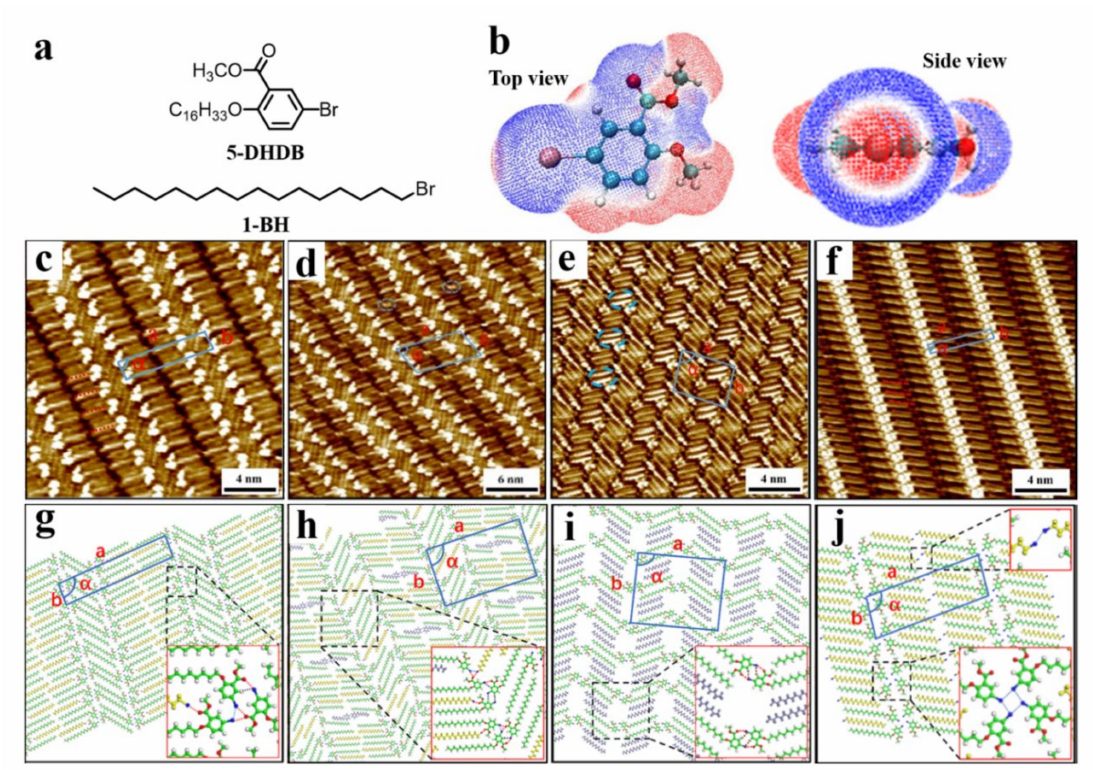
Figure 5. ( a ) Chemical structures of 5-BHDB and 1-BH. ( b ) Top and side views of the calculated 3D ESP map of 5-BHDB molecule. ( c – f ) High-resolution STM images showing the self-assembled linear